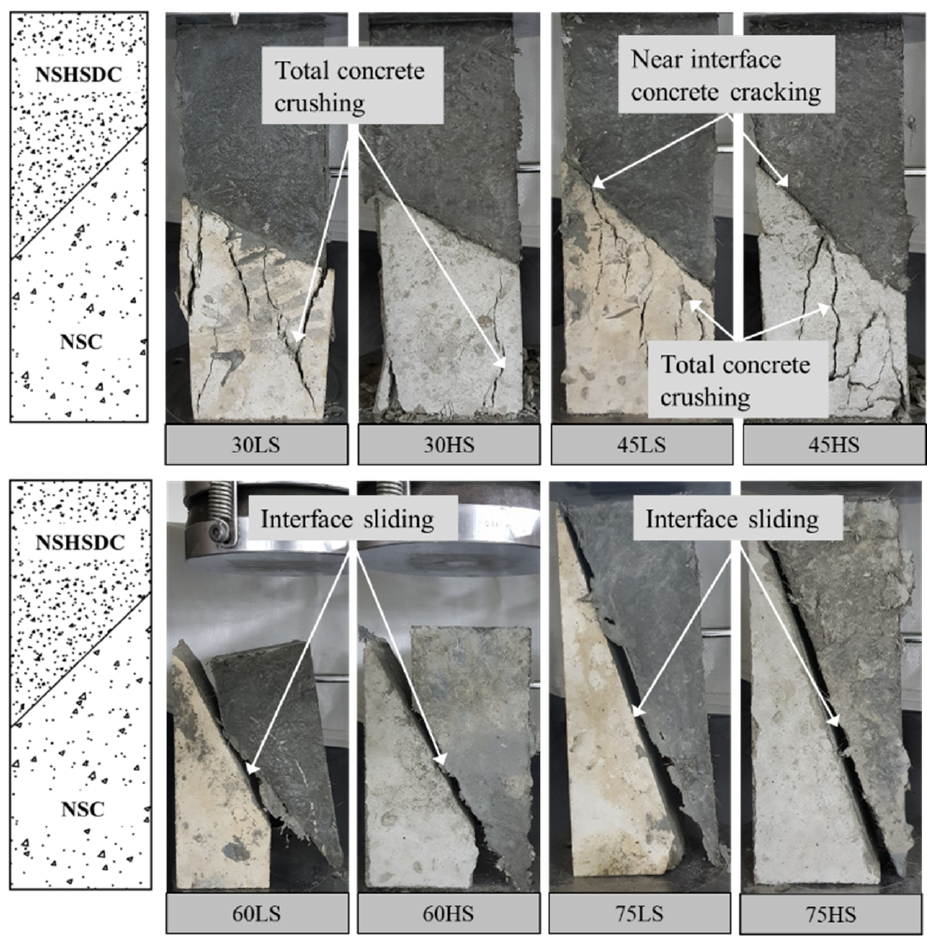
Figure 5. Failure mode of slant shear strength test.